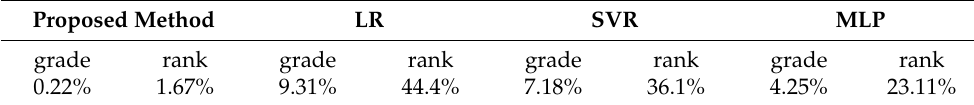
Table 6. Prediction Performances (MAPE) of Different Methods for Student 14295.